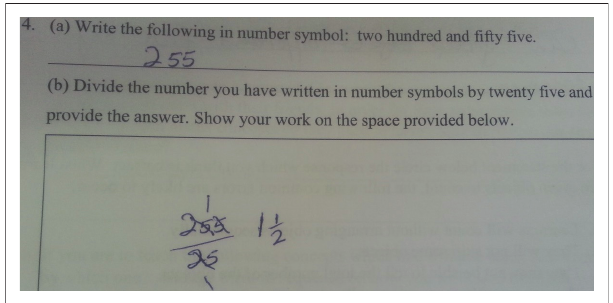
FIGURE 5: Response of Teacher 5.